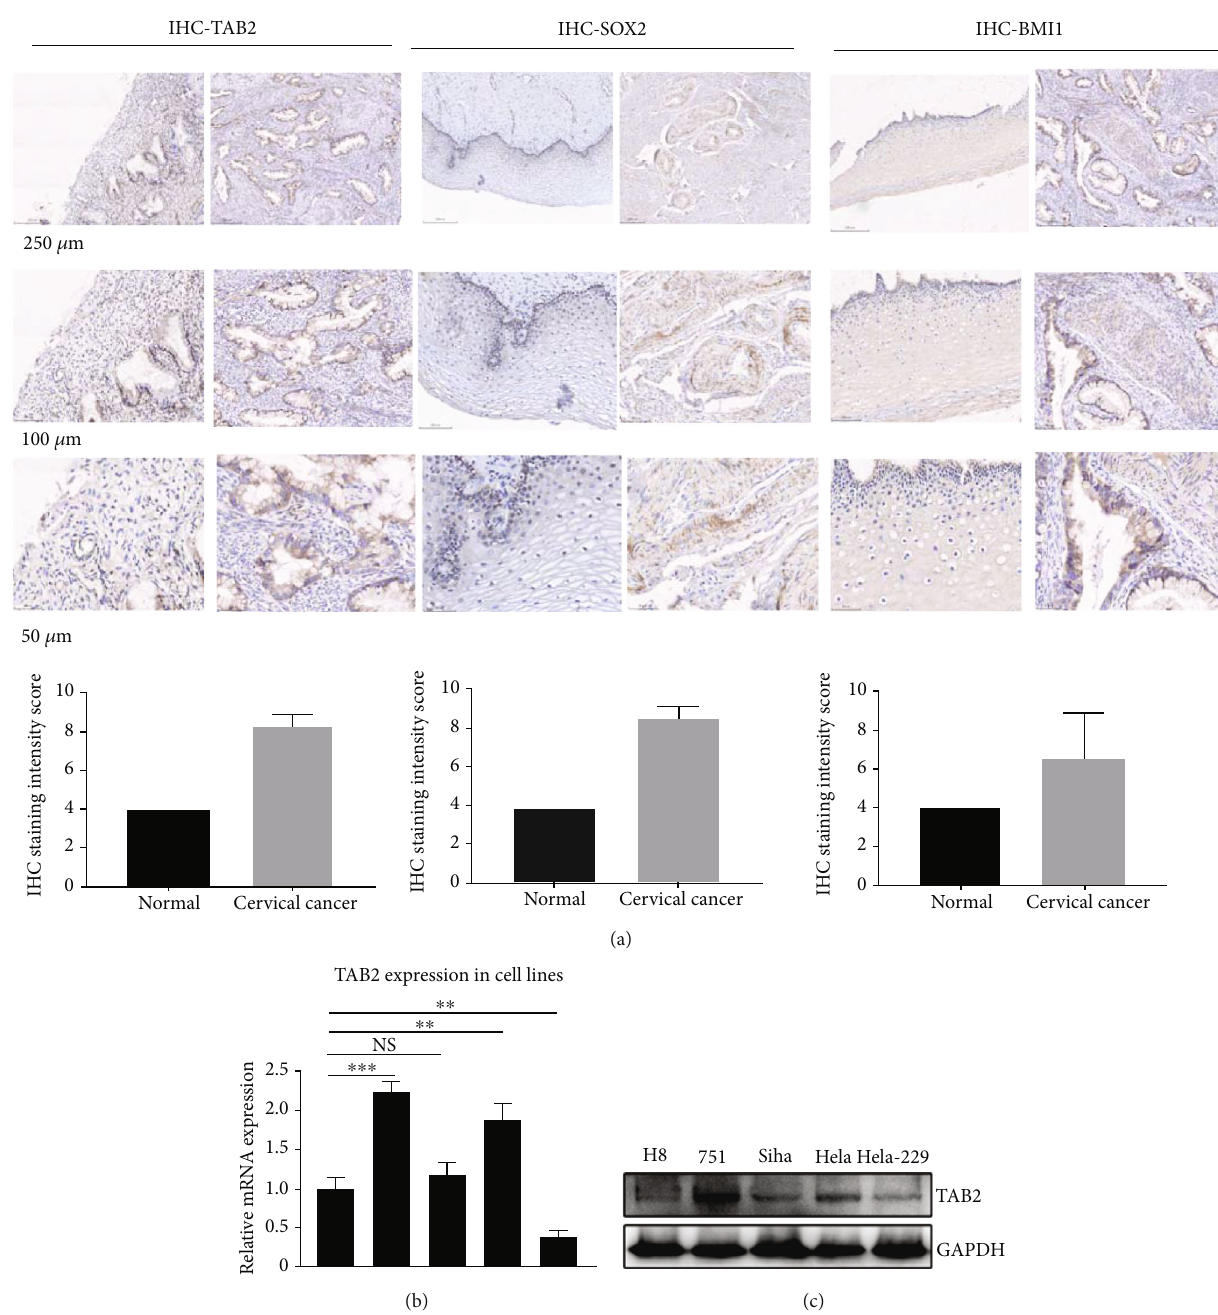
Figure 3: The expression of TAB2 in cervical cancer. (a) IHC staining showing that positive expressions of TAB2 and SOX2 were signi fi cantly high in cervical cancer. (b) The mRNA expression of TAB2 in cervical cancer cell lines was tested by qPCR experiment. (c) The protein level of TAB2 in di ff erent cervical cancer cell